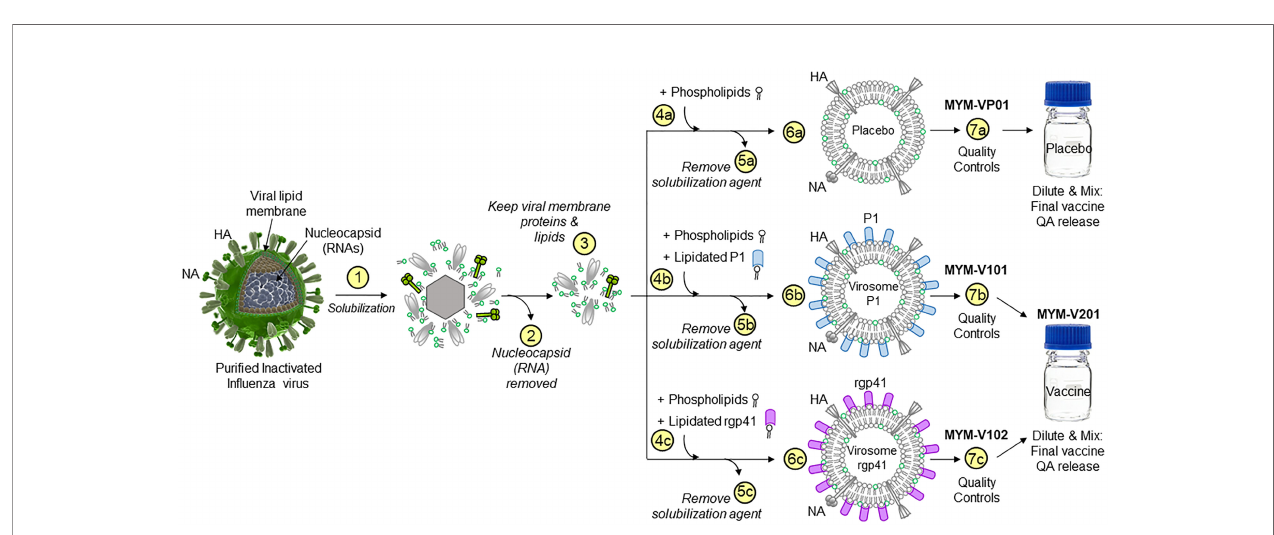
FIGURE 2 | Production schema to generate HIV-1 gp41 virosomes. The production of unadjuvanted placebo virosomes (MYM-VP01), as well as unadjuvanted virosome-P1 (MYM-V101) and virosome-rgp41 (MYM-V102) is based on components derived from in fl uenza virus membranes. Step 1, inactivated in fl uenza A/H1N1 is solubilized with detergent; Step 2, nucleocapsids are discarded; Step 3, the viral membrane lipids with the native in fl uenza hemagglutinin (HA) and neuraminidase (NA) are recovered and used as carriers for vaccinal antigens. The following steps are speci fi c to each virosomal vaccine: Step 4a for placebo virosomes; only synthetic phospholipids are mixed with the in fl uenza virus-derived components, while the antigen P1 (Step 4b, blue rods) or rgp41 (Step 4c, pink rods) is mixed with synthetic phospholipids. During gradual removal of the detergent in Steps 5a-5c, placebo virosomes (6a), virosome-P1 (6b), and virosome-rgp41 (6c) are gradually assembled in vitro . To generate the HIV-1 liquid virosomal vaccine, virosome-P1 (MYM-V101) and virosome-rgp41 (MYM-V102) are then diluted, combined, and mixed to achieve the target antigen concentration of the fi nal HIV-1 vaccine MYM-V201. Quality control is performed to verify that values for particle size, particle population homogeneity, antigen and HA content are within the prede fi ned speci fi cities.